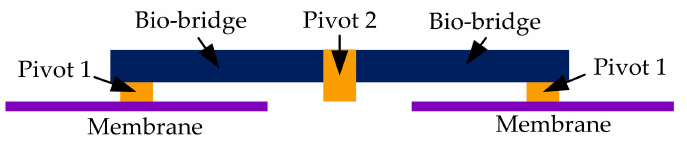
Figure 9. The structure diagram of the established intermembrane bridge